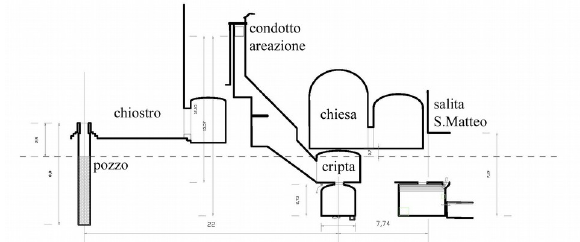
Figure 6. Schematic section of the church with crypt, underneath area, lateral cloister, and well (R.